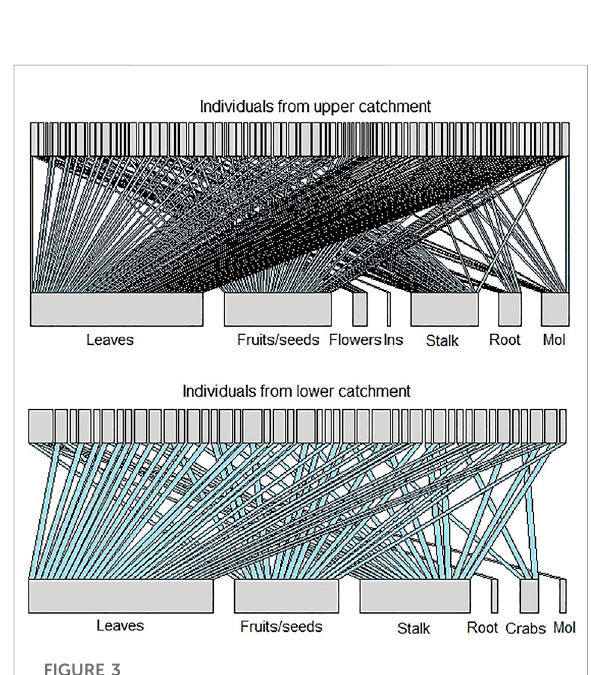
FIGURE 3 Bipartite graph showing the relationship between Piaractus mesopotamicus individuals and their diet resource in the upper catchmentand inthe lowercatchmentpopulations. The thickness